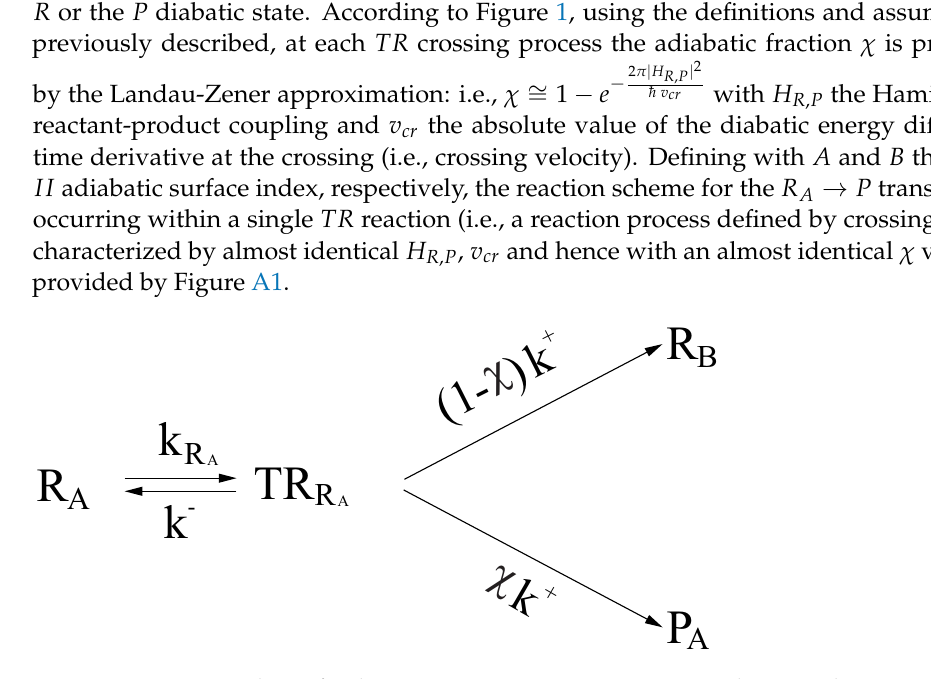
Figure A1. Reaction scheme for the R A → P transition as occurring within a single TR reaction (see text). TR R represents the TR ensemble provided by the reactive trajectories entering the transition A region from R A . A similar scheme can be used for the R B → P